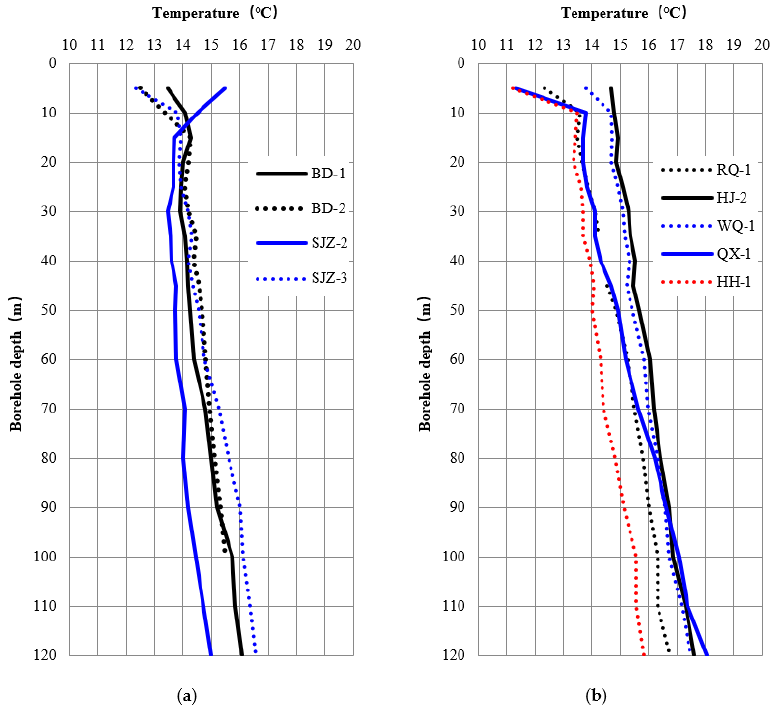
Figure 3. Undisturbed ground temperature profile: ( a ) the piedmont pain; ( b ) the central and coastal plain.